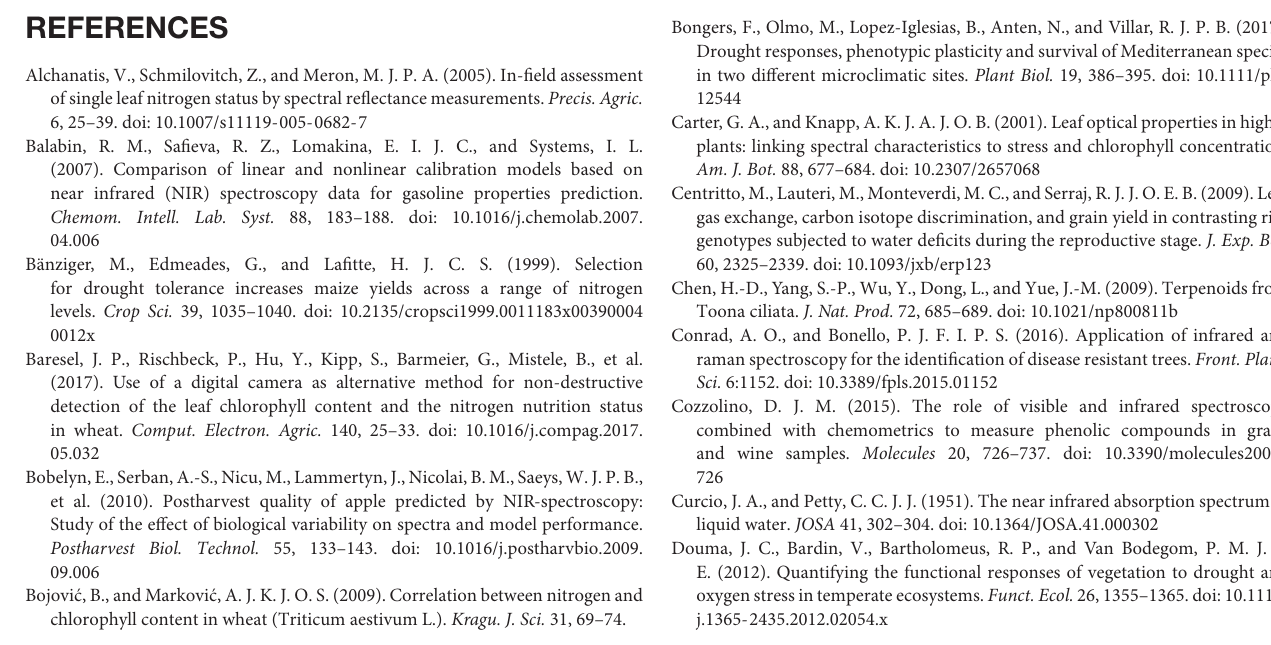
Supplementary Figure 1 | Linear fitting graph of PLS modeling results of T. sinensis seedling chlorophyll content based on five spectral preprocessing and four variable selection methods. Red represents the optimal model for predicting. Supplementary Figure 2 | Linear fitting graph of PLS modeling results of T. sinensis seedling Nitrogen content based on five spectral preprocessing and four variable selection methods. Blue represents the optimal model for predicting. Supplementary Figure 3 | PLS modeling results of chlorophyll (A) and nitrogen (B) content of T. sinensis seedlings based on five spectral preprocessing and four variable selection methods. R2cal: corrected correlation coefficient, R2val: verified correlation coefficient, RMSEcal: corrected root mean square error, RMSEval: verified root mean square error. Red represents the optimal model for predicting chlorophyll content, and blue represents the optimal model for predicting nitrogen